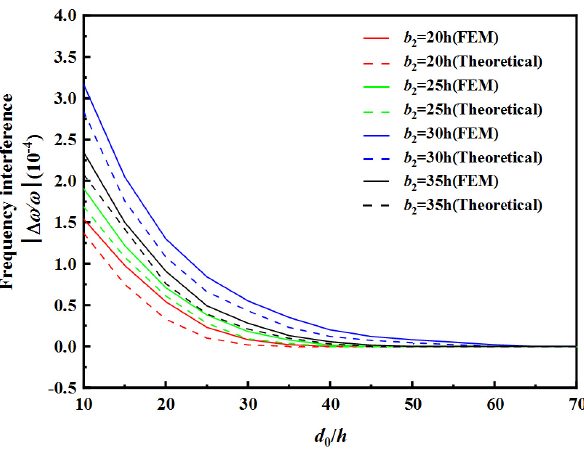
Figure 9. Influences of RU-B’s electrode width on the frequency interference.